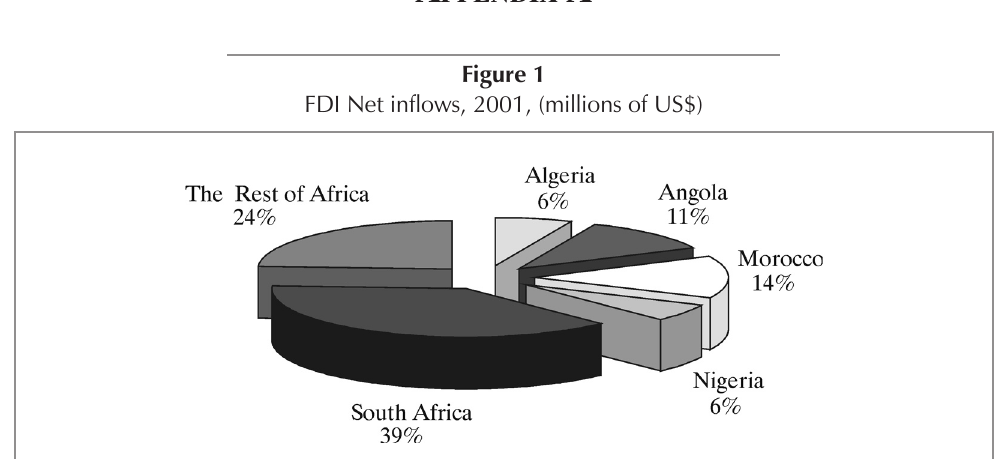
Source: Authors’ calculations based on data from World Bank, 2002